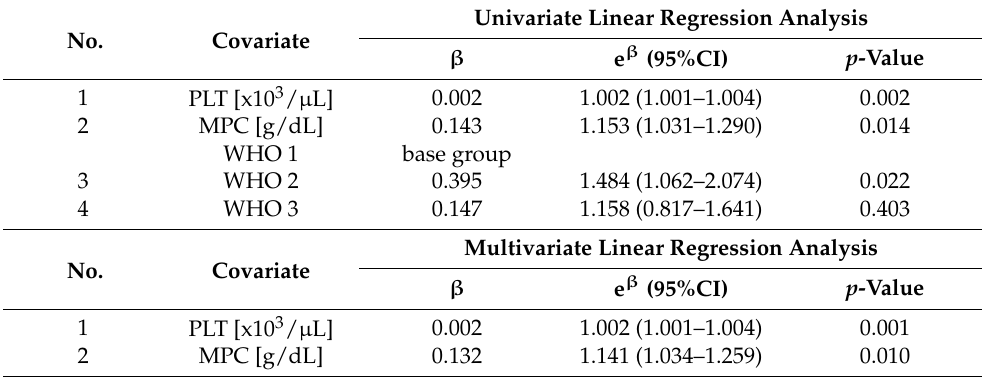
Table 4. Univariate and multivariate linear regression analysis results for sCD40L in colorectal cancer